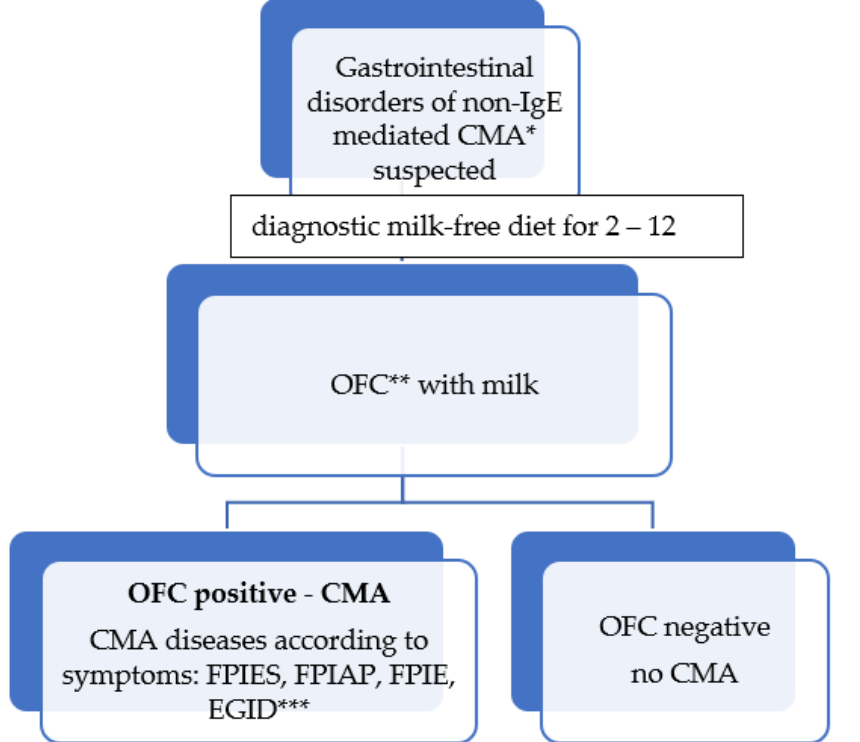
Figure 1. Gastrointestinal disorders of non-IgE mediated CMA diagnosis scheme * CMA—cow’s milk allergy; ** OFC—Oral Food Challenge; *** CMA diseases according to symptoms: FPIES—food protein-induced enterocolitis syndrome, FPIAP—food protein-induced proctocolitis, FPIE—food protein-induced enteropathy syndrome, EGID—syndromes of eosinophilic gastrointestinal diseases.